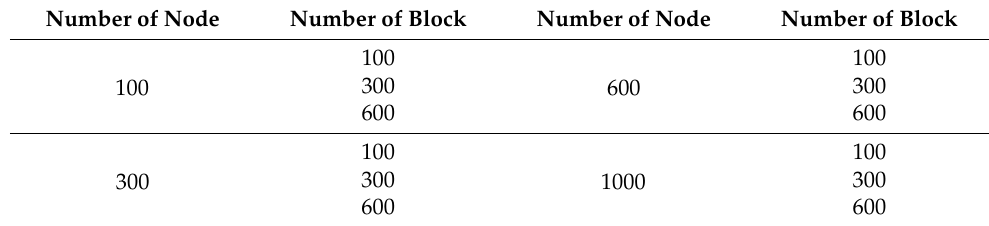
Table 3. Parameter setting for SimBlock simulator testing.